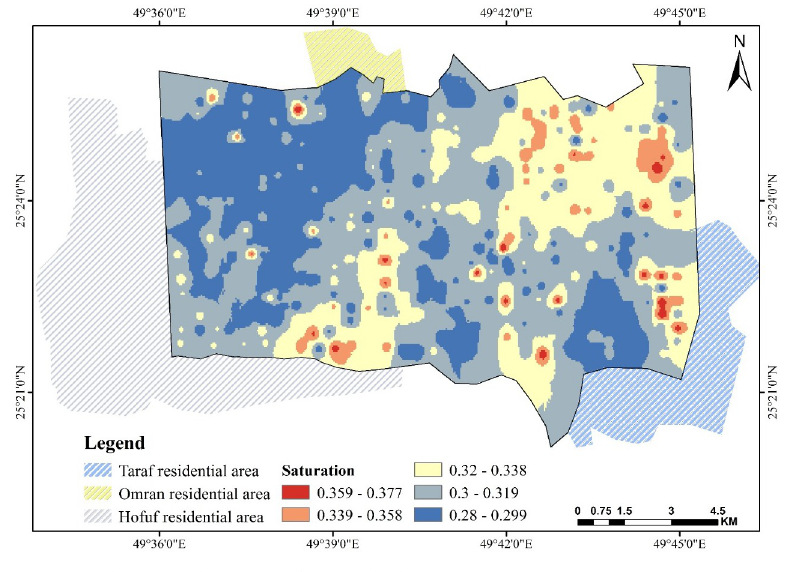
Fig 6. Spatial pattern of saturation θ s over Al-Ahsa.